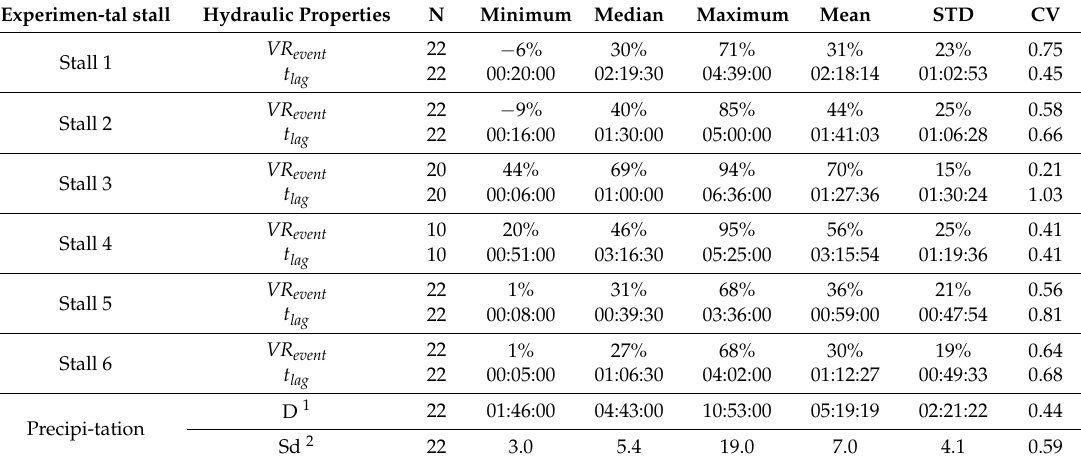
Table 3. Descriptive statistics for individual storm events included in the analysis of volume reduction ( VR event ) and lag-time ( t lag ) to the experimental stalls as well as storm duration and storm depth. Experimen-tal